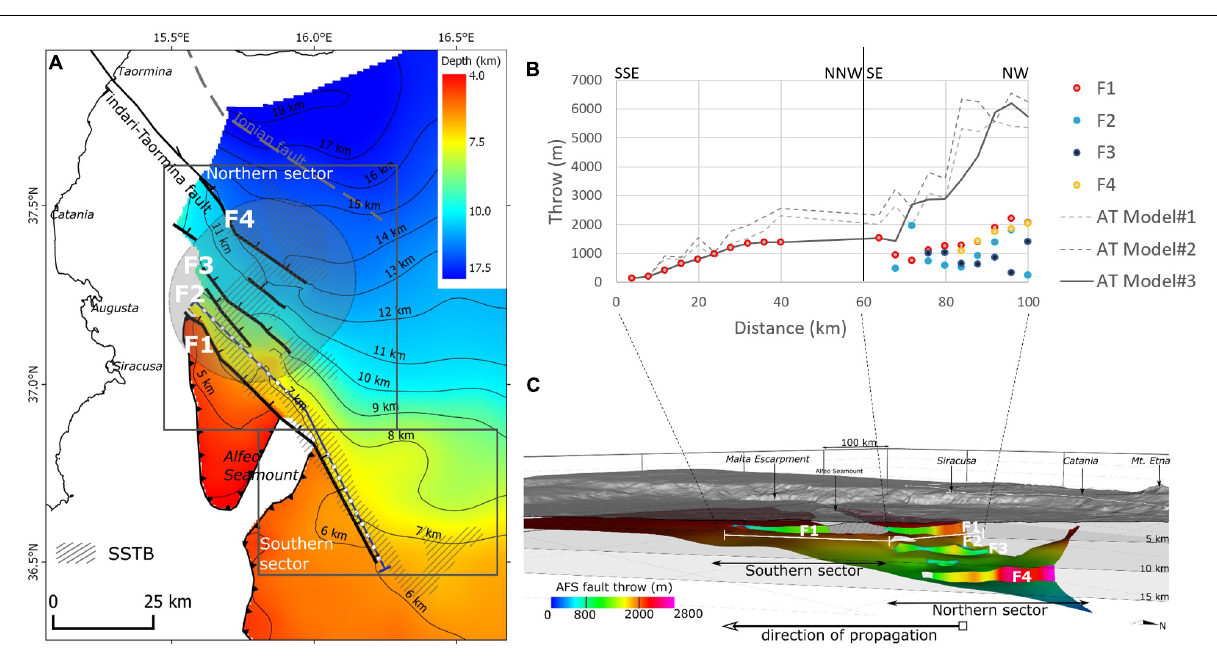
FIGURE 7 | (A) Map of the AFS displacing the Calabrian subduction interface. F1–F4 are the fault segments identified in the analysis of the seismic reflection profiles shown in Figures 3 – 5 . (B) Profile of the throw along the AFS measured on the slab interface. The dots are the throw point-measurements taken in each single fault segment (F1–F4) adopting the velocity Model #3 for the time-depth conversion ( Table 3 ). The solid line represents the aggregated throw (AT) from all fault segments. The dark-gray dashed line and the light-gray dashed line are the aggregate throw obtained from the alternative velocity Model #2 and velocity Model #1 ( Table 3 ) shown here for comparison. (C) Easterly 3D view of the AFS; fault-plane color shading represents the vertical throw along the